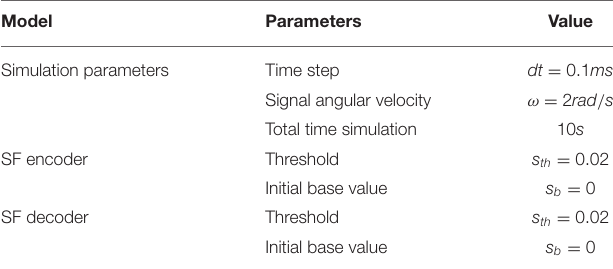
TABLE 2 | Step Foward + STDP Encoding